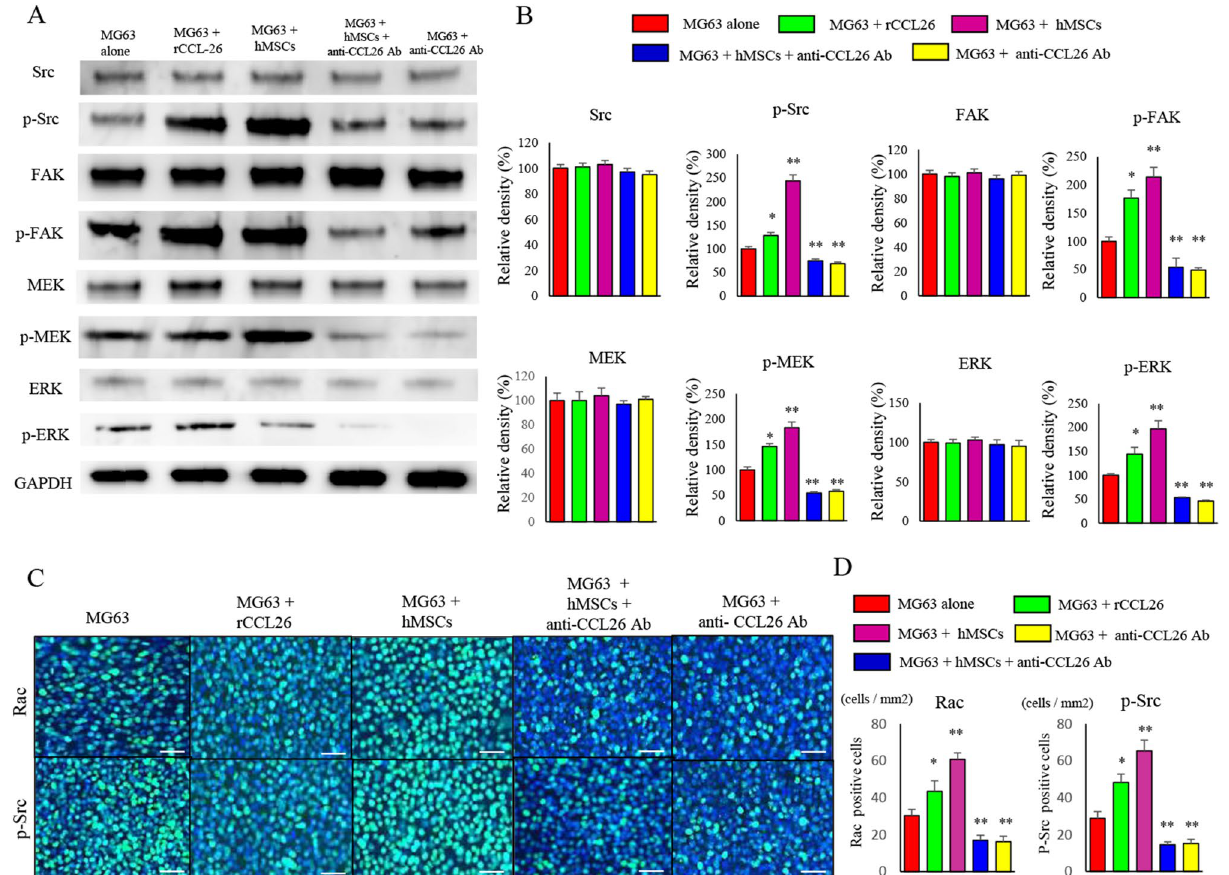
Figure 5. Changes in expression of Src and its downstream factors related to invasive potential. ( A ) Changes in phosphorylation and the expression of protein factors relating to invasive potential were analyzed. Decreased phosphorylation of Src, FAK, MEK and ERK in MG63 cells was noted in the group administered anti-CCL26 Ab. ( B ) The quantification of western blot analysis. ( C ) Immunofluorescence staining of cultured MG63 cells showed decreased CCL26 and p-Src in the group administered anti-CCL26 Ab. Original magnification, × 400; Scale bars: 50 μm. ( D ) The number of Rac and p-Src positive cells per unit area. Data represents represent the mean ± SD of three independent experiments. p < 0.05 was considered to indicate significance: (*) p < 0.05, (**) p <